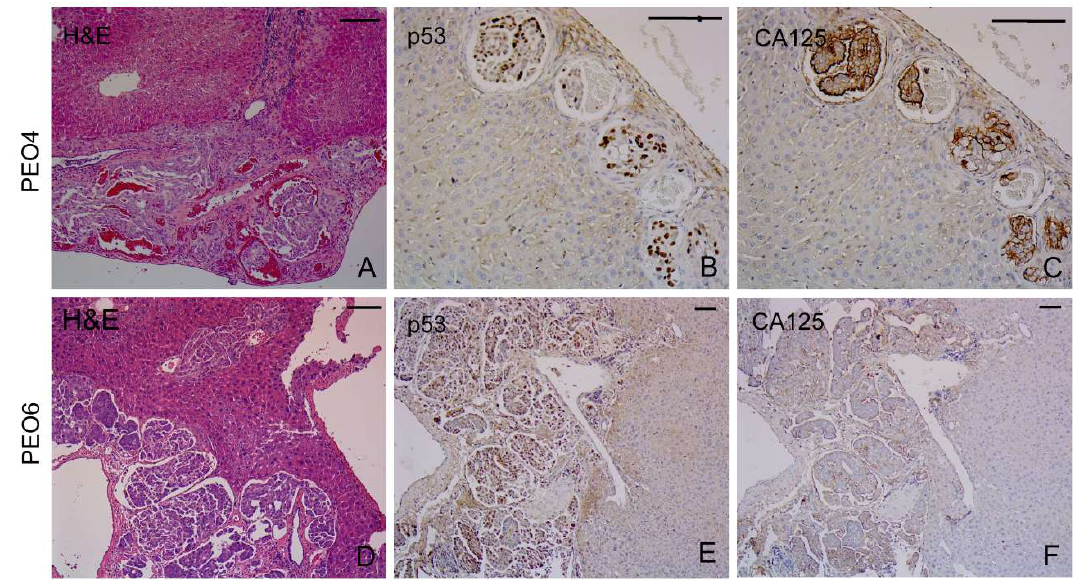
Figure 7. Metastases at the base of the liver. Images show sections of tumoral tissue derived from PEO4 cells ( A – C ) or PEO6 cells ( D – F ). PEO4 cells show positivity for p53 and CA125 ( B , C ), whereas similar results are observed for PEO6 cells ( E , F ). Scale bars = 50 μm.